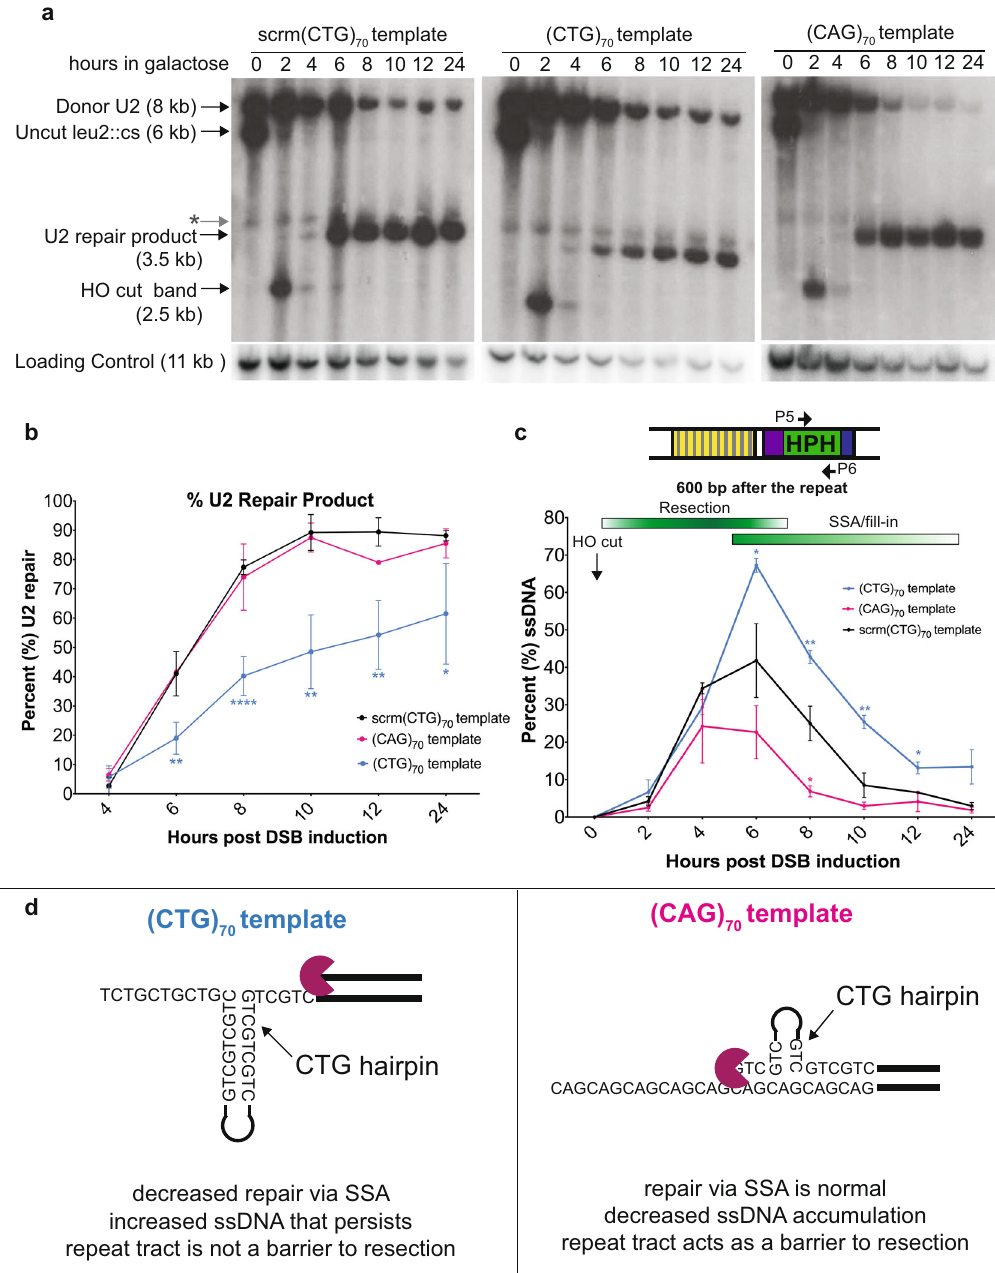
Fig. 2 | Identity of the repeat on the template strand results in alterations in repair kinetics during gap fi lling. a Southern blot analysis after addition of 2% galactose to induce a DSB within LEU2 . Representative Southern blot is shown; number of replicates: scrm(CTG) 70 n =3, (CTG) 70 n =4, (CAG) 70 n =3. U2 probe locationismarkedinFig.1a;loadingcontrolprobeistoaportionofthe TRA1 gene. Non-speci fi c hybridization of the probe is marked with a gray star. b U2 repair measurement (%) on Southern blots after DSB induction. Number of replicates measured: